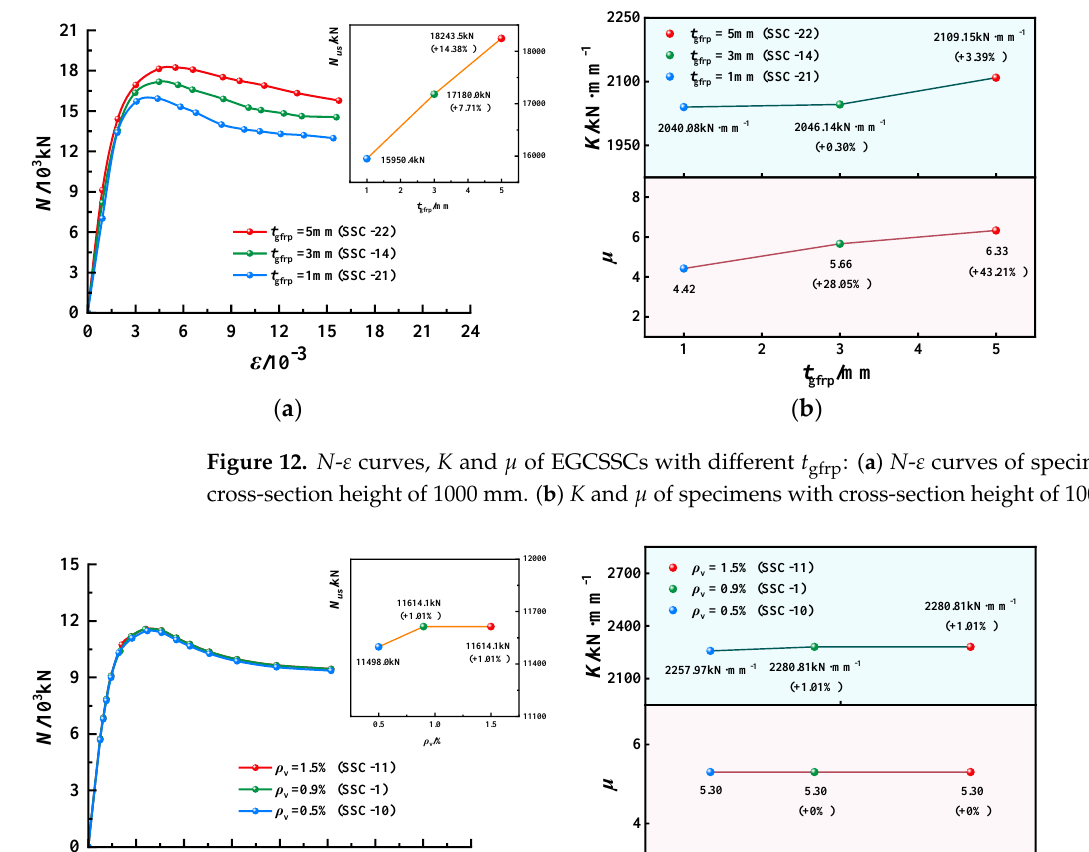
Figure 11. N - ε curves, K and µ of EGCSSCs with different t gfrp : ( a ) N - ε curves of specimens with cross-section height of 800 mm. ( b ) K and µ of specimens with cross-section height of 800 mm.